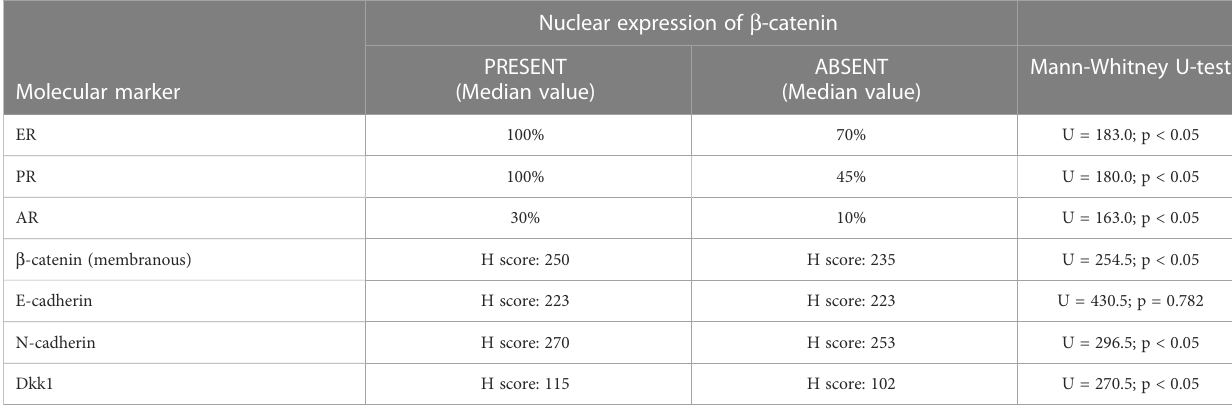
TABLE 2 Correlations between expression of hormone receptors and molecular markers in tumours with and without nuclear expression of b - catenin.